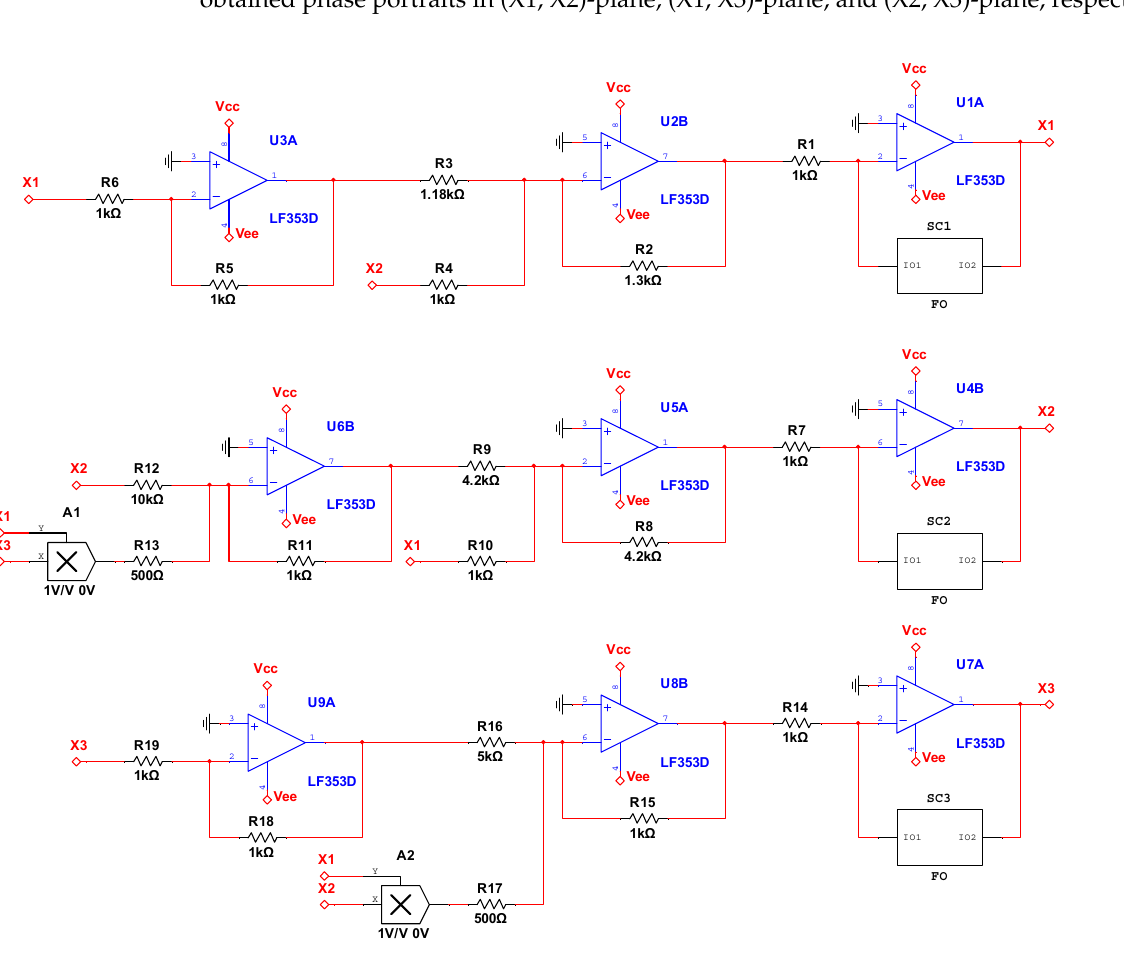
Figure 9. The schematic circuit of the fractional-order chain system.